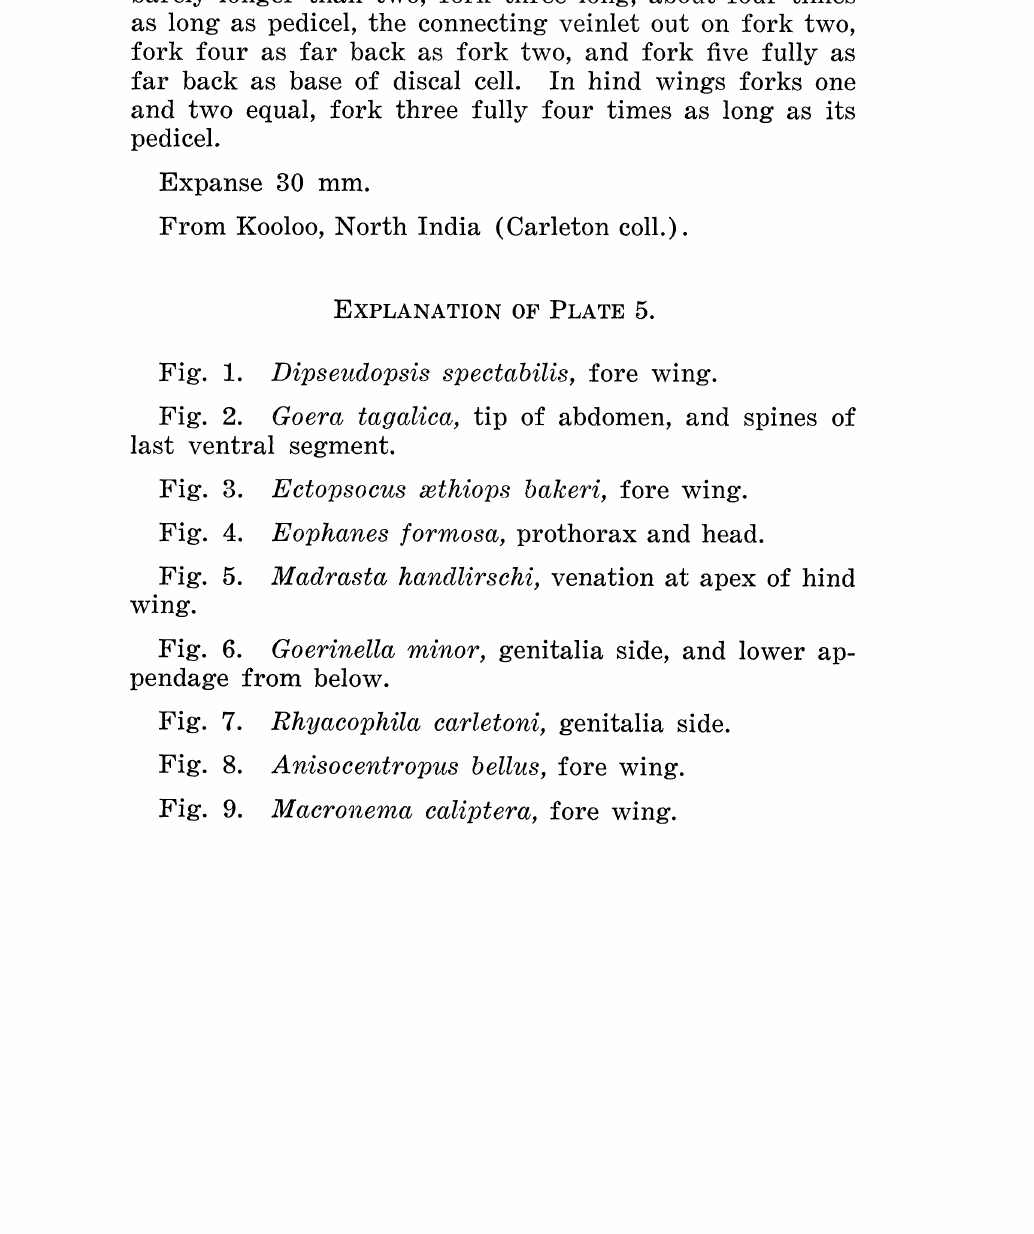
Fig. 1. Dipseudopsis spectabilis, ore wing. o abdomen, Fig. 2. Goera tagalica, tip and spines of last ventral segment. Fig. 3. Ectopsocus tvthiops bakeri, ore wing. Fig. 4. Eophanes formosa, prothorax and head. Fig. 5. Madrasta handlirschi, venation at apex of hind wing. Fig. 6. Goerinella minor, genitalia side, and lower ap- pendage rom below. Fig. 7. Rhyacophila carletoni, genitalia side. Fig. 8. Anisocentropus bells, fore wing. Fig. 9. Macronema caliptera, 2ore